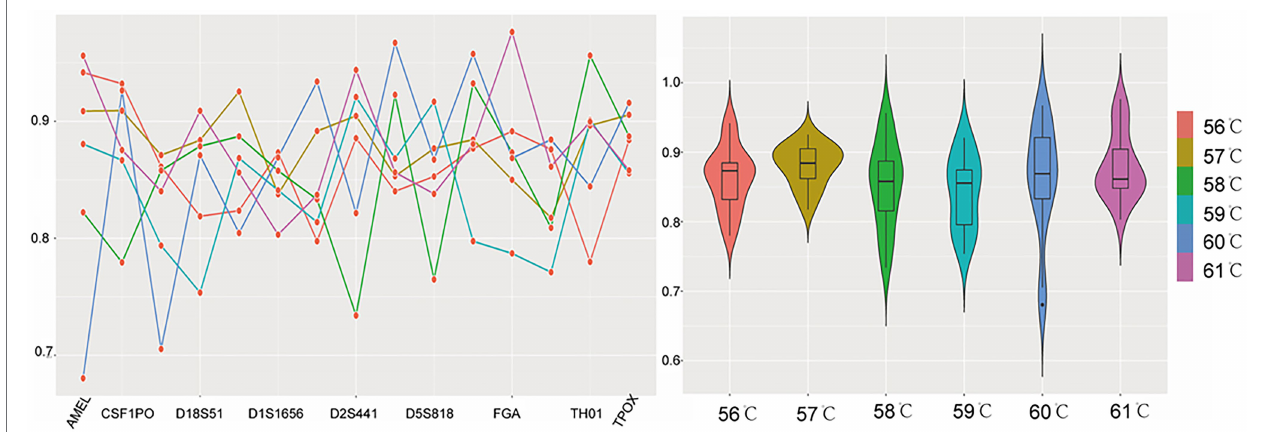
FIGURE 1 | The peak height ratio (PHR) performance when annealing temperature was set at 56, 57, 58, 59, 60, and 61 ° C. Each temperature was represented by a corresponding color. For the line chart on the left, the x -axis listed the loci, and the y -axis was the PHR. The red dots of the line chart represented PHR values of locus AMEL, CSF1PO, D12S391, D18S51, D19S433, D1S1656, D21S11, D2S441, D3S1358, D5S818, D8S1179, FGA, Penta D, TH01, and TPOX, respectively. For the violin plot on the right, the y -axis still was PHR, while the x -axis was the annealing temperature. The violin plot showed the distributions of these PHR values when different annealing temperatures were